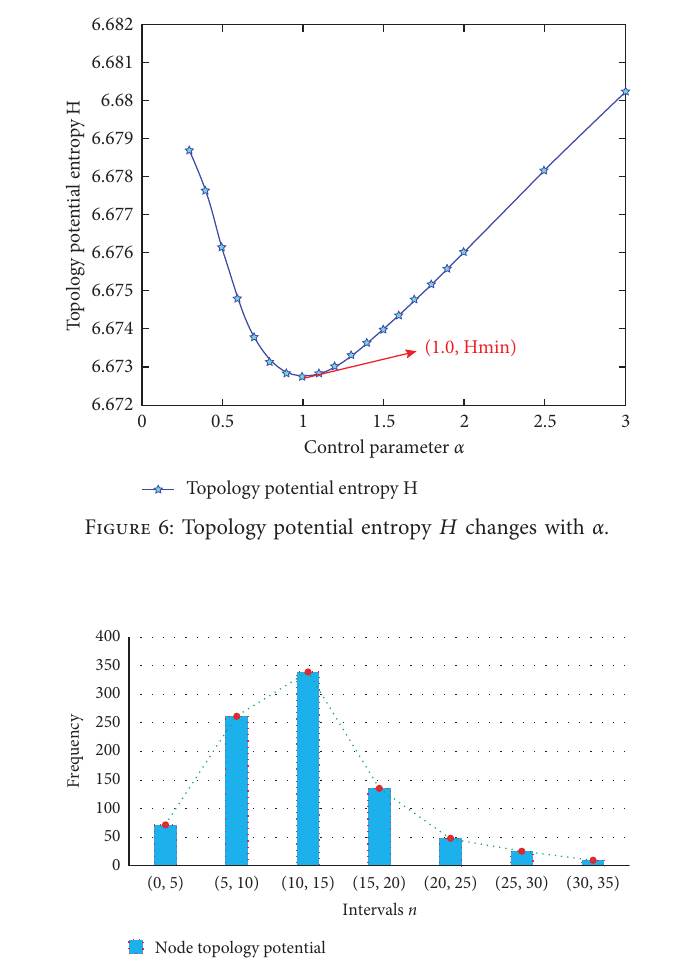
Figure 7: The distribution of ARRN nodes topology potential.